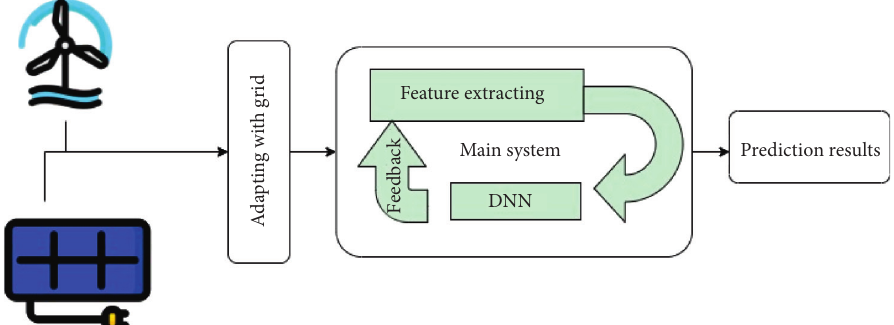
Figure 7: The proposed method within the